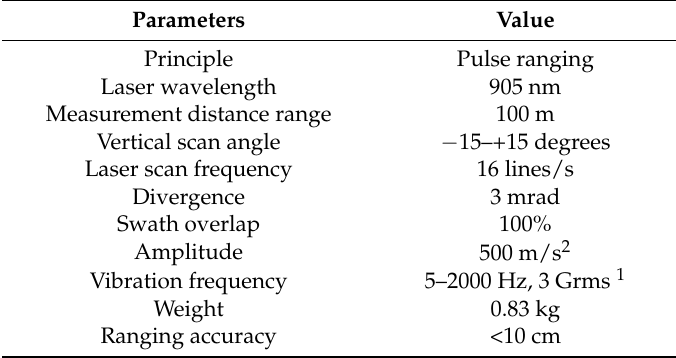
Table 2. Specifications of the Velodyne 16E laser scanner